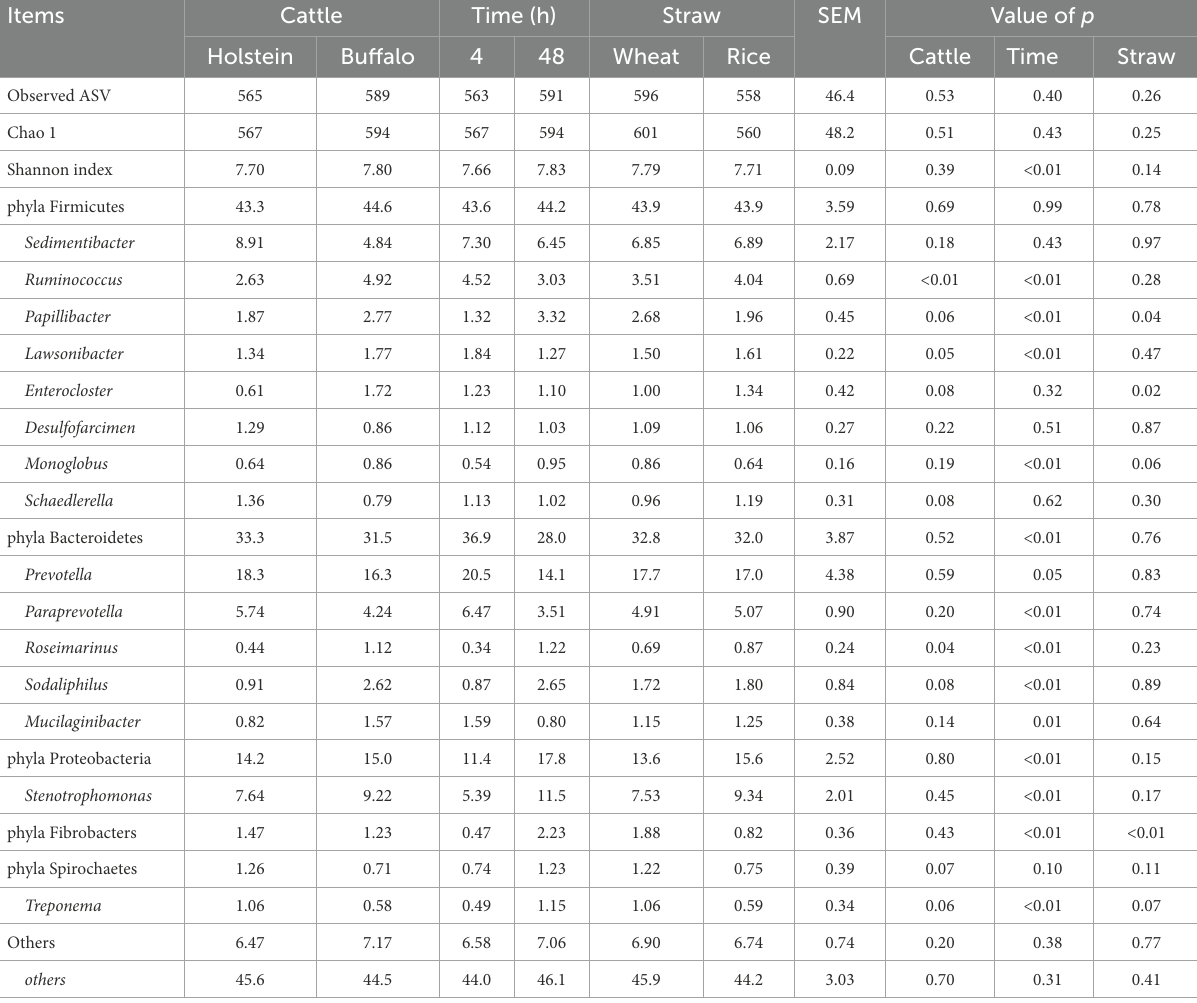
TABLE 4 Relative abundance (%) of bacterial community attached to rice and wheat straws at 4 and 48 h of in situ incubation time in buffalo and Holstein rumen.